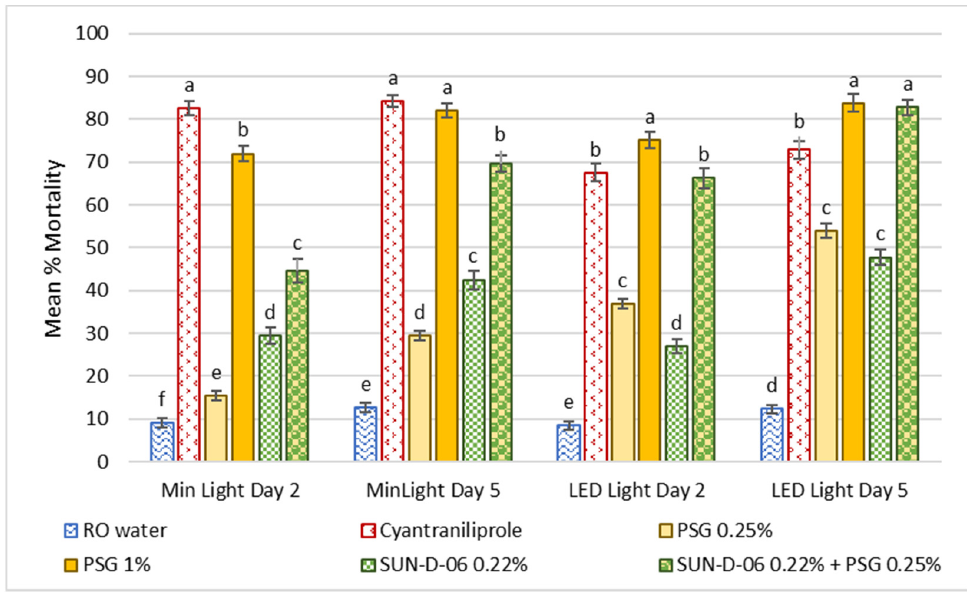
Figure 3. Mean percentage mortality of western flower (WFT) after feeding on treated cabbage leaf discs for two and five days, respectively, in the ingestion assay. Error bars denote standard error, and bars with the same letters indicate treatments that were not significantly different ( p > 0.05).